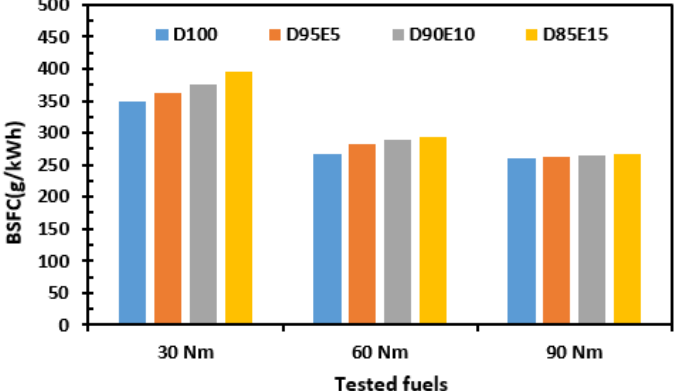
Figure 5. Maximum heat release rate for all test fuels according to various engine loads.